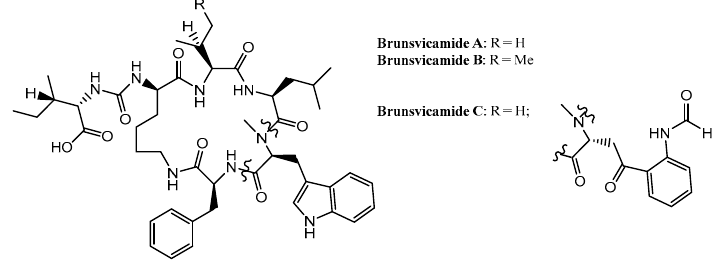
Figure 9. Structures of Brunsvicamides